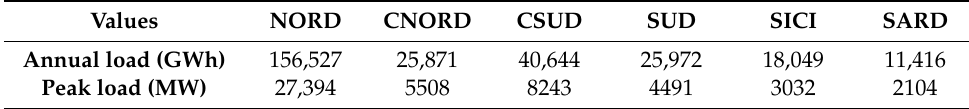
Table 3. Annual consumption and peak load values in the six Italian